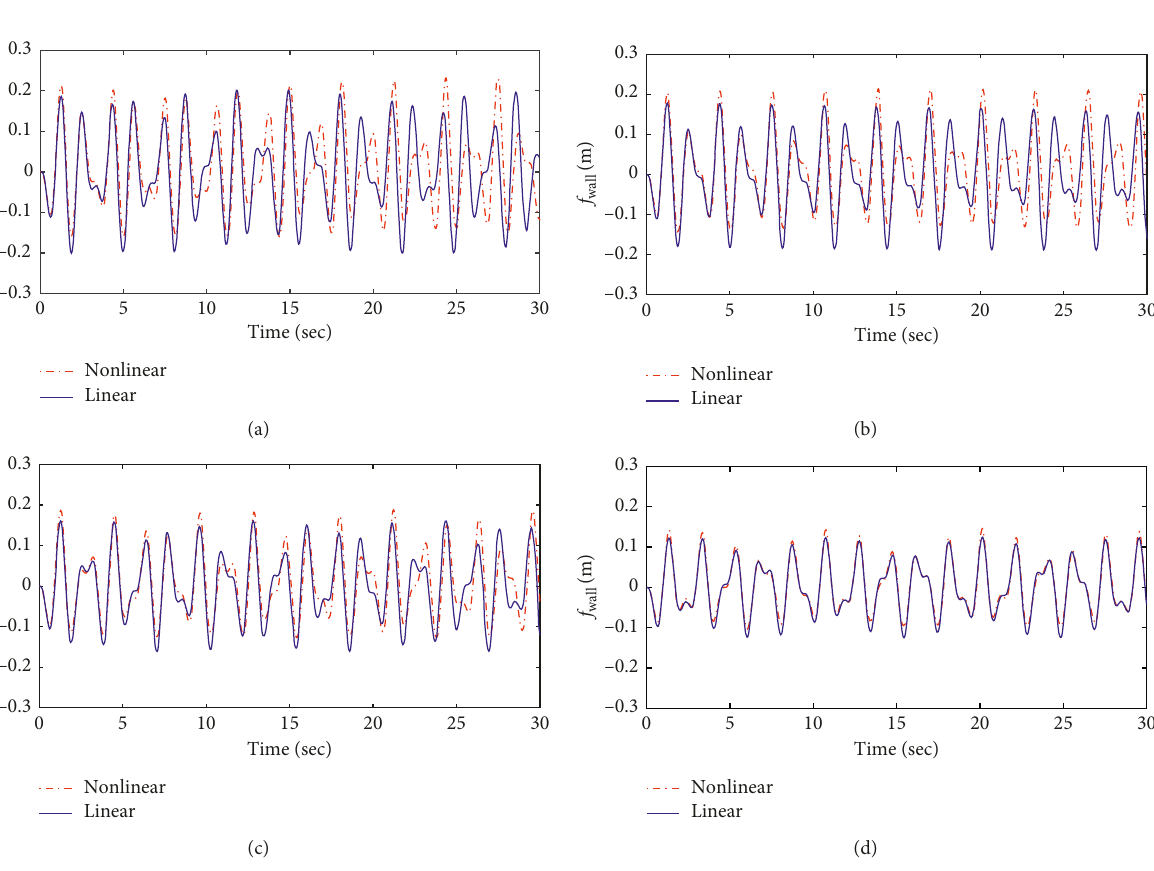
Table 2: The resultant hydrodynamic force and moment from liquid below/above the baffle versus the position of the baffle for r Resultant force and moment from liquid below/above the baffle